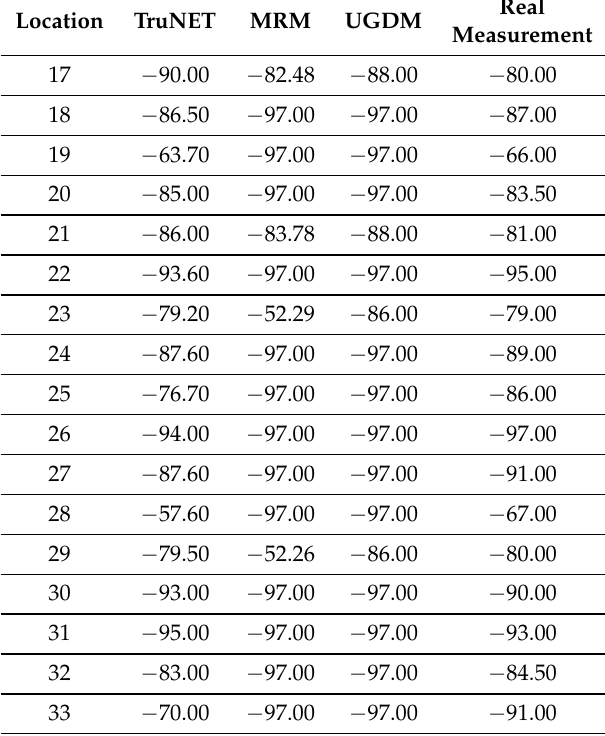
Table 4. RSS Comparison—WSN Setup